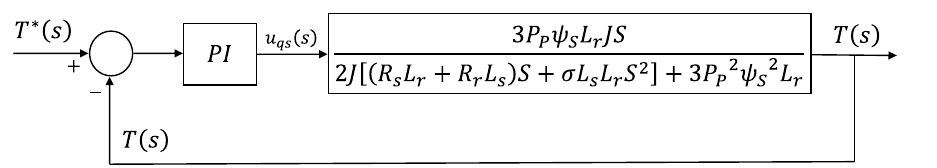
Figure 6. Torque block diagram.